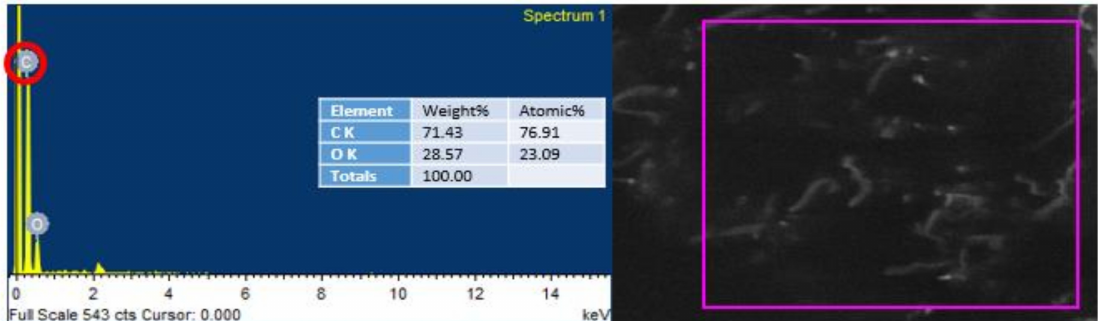
Figure 8. EDS analysis of urea–formaldehyde resin with 4%